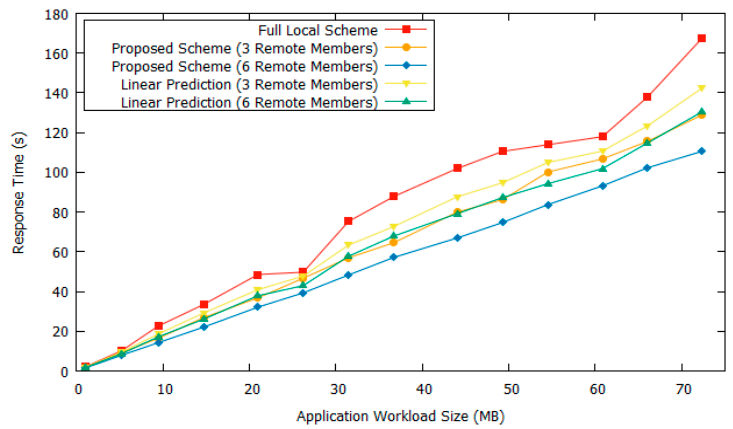
Figure 6. Response time comparison with 40 GHz bandwidth.